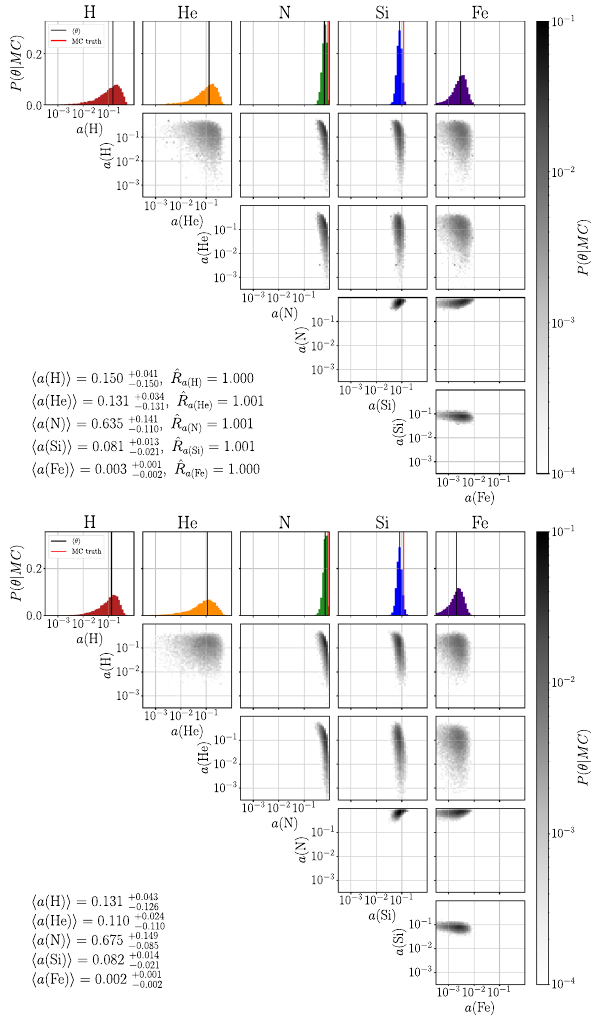
Fig. 6 Posterior distributions of the composition fractions obtained withtheMCMC(upper)andthecINN(lower)methods.Themeanofthe distributions is shown by the black solid curve and the true underlying value of the benchmark simulation is marked by the red curve. In the lower left of the plots of both methods, the mean and standard deviation of both parameters are shown and for the MCMC also the Gelman– Rubin index ˆ R